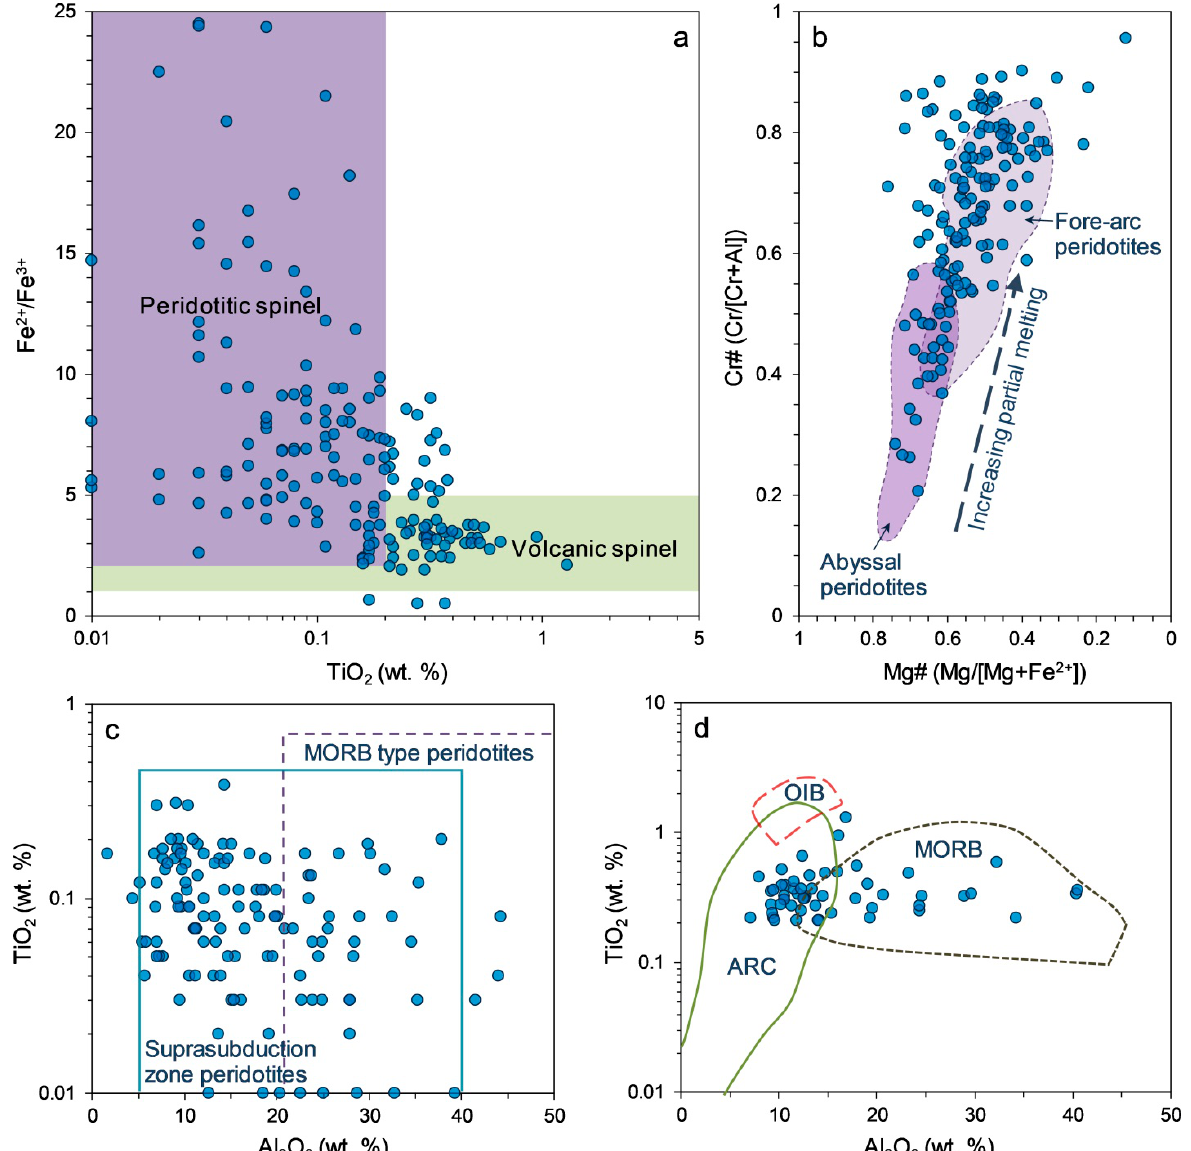
Figure 18. Discrimination diagrams for chromspinels of Sabantuy paleoplacer: ( a ) TiO 2 vs. Fe 2+ /Fe 3+ showing the compositions of all detrital chromspinels studied, peridotite and volcanic chromspinel fields are taken from [13]; ( b ) Mg# vs. Cr# for peridotite chromspinels, and fields are taken from [62]; ( c ) Al 2 O 3 vs. TiO 2 for peridotite chromspinels, and fields are taken from [52]; ( d ) Al 2 O 3 vs. TiO 2 for volcanic chromspinels, and fields are taken from [45]. MORB—middle ocean ridge basalts; ARC—island arc magmas; OIB—oceanic island basalt.